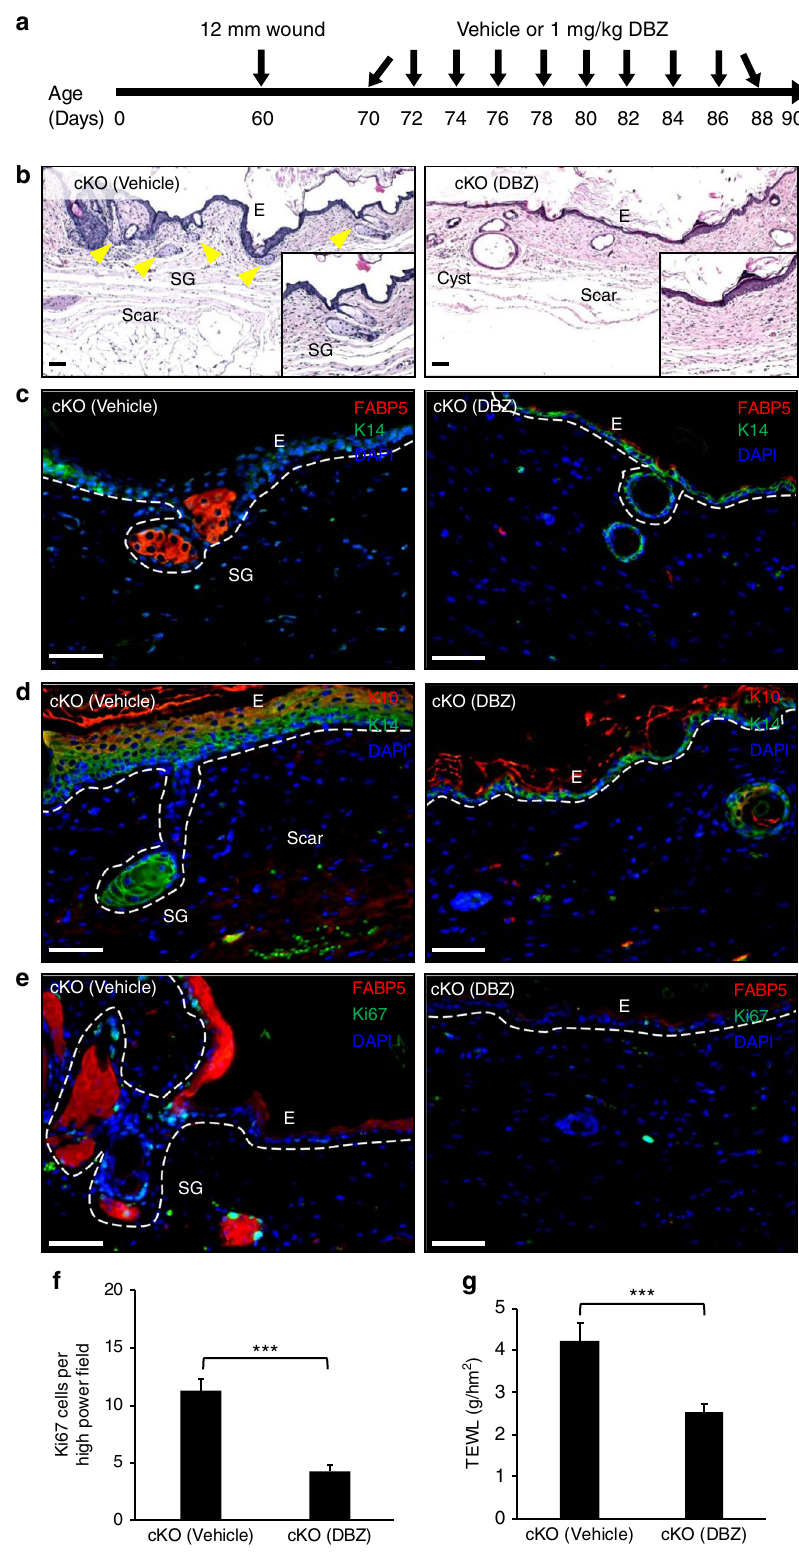
treated mice a signi fi cant reduction in TEWL was found when compared to the vehicle treated group (Fig. 7g). These data indicate a marked restoration of the impaired barrier function in JunB cKO skin.